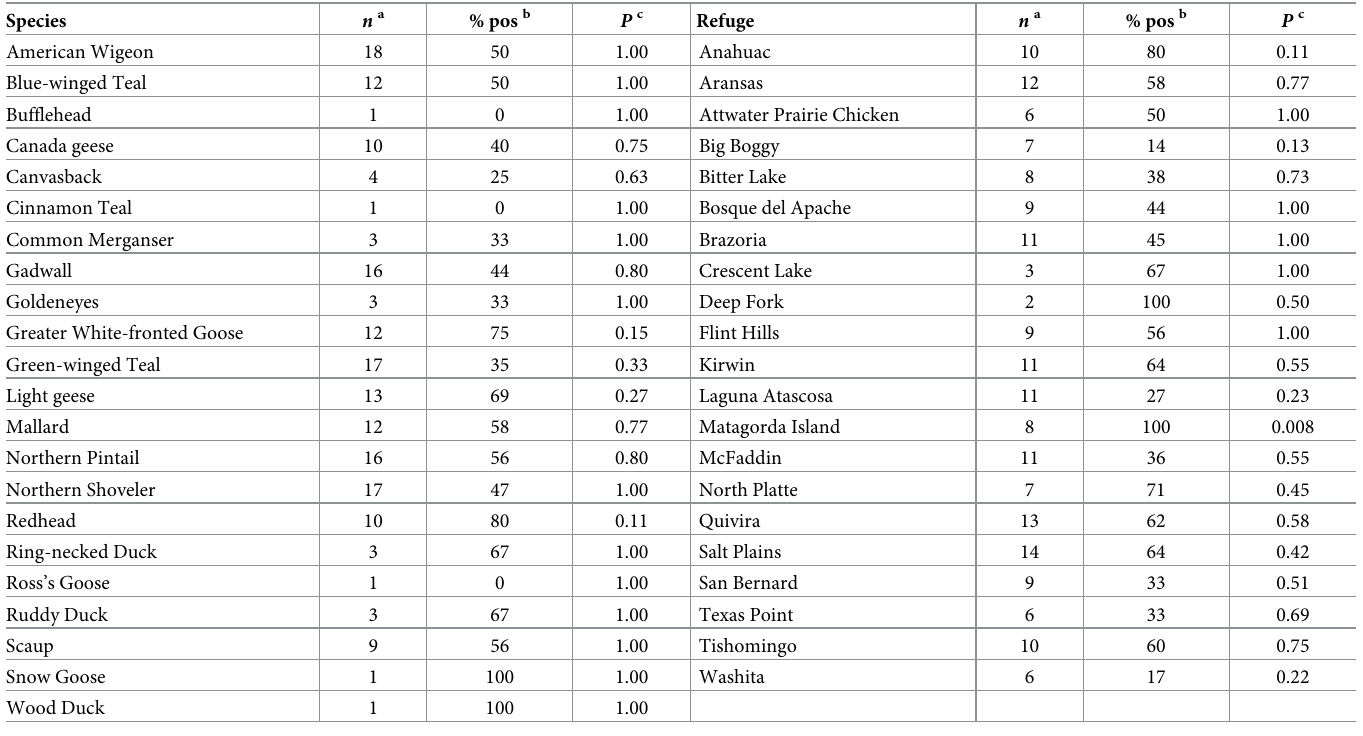
Table 2. Skewness in the distribution of slopes indicating advancements or delays in autumn peak across years by waterfowl species and refuge. n